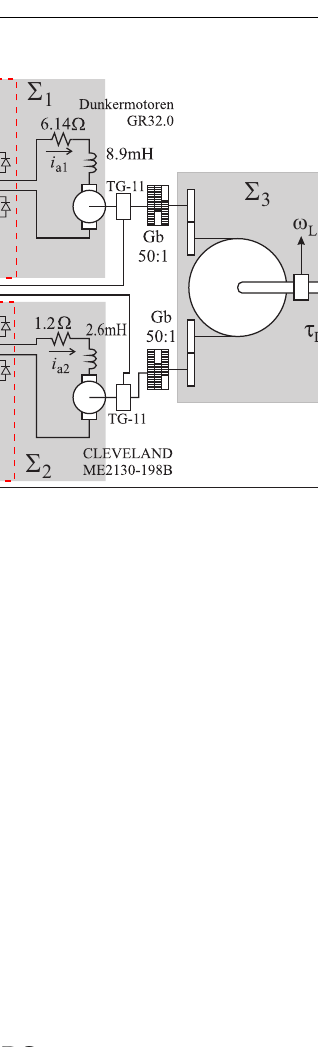
Figure 6. Servomechanism drives by two brushed DC